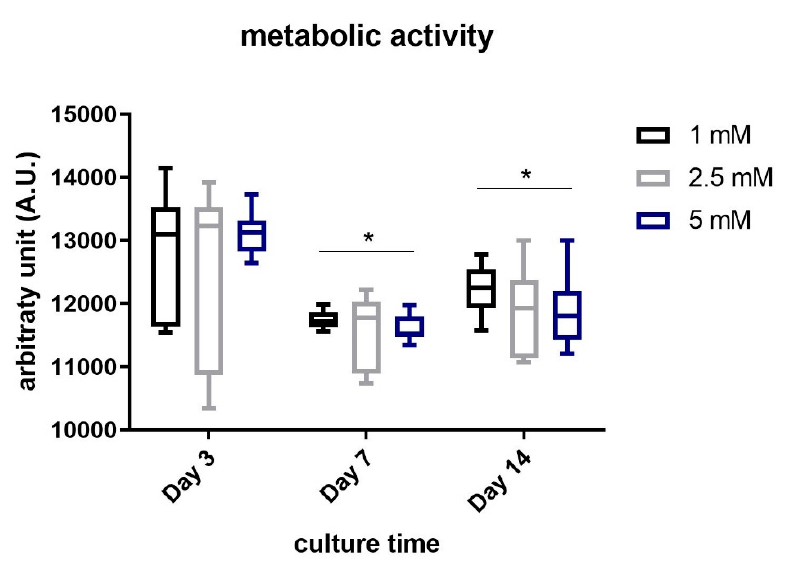
Figure 7. Metabolic activity of human chondrocytes embedded in JellaGel™ hydrogels crosslinked with genipin at different concentrations, after 3, 7, and 14 days of culture. * = p < 0.05.